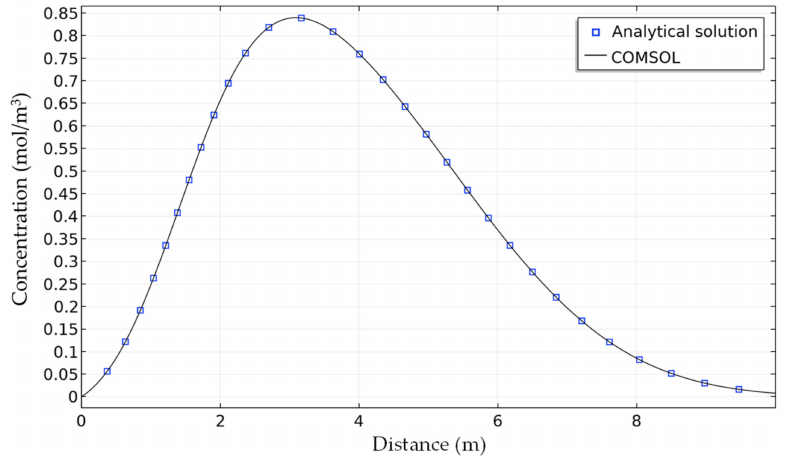
Figure 5. Comparison between COMSOL 1D transport model and analytical solution in the case of the transient-conservative tracer.